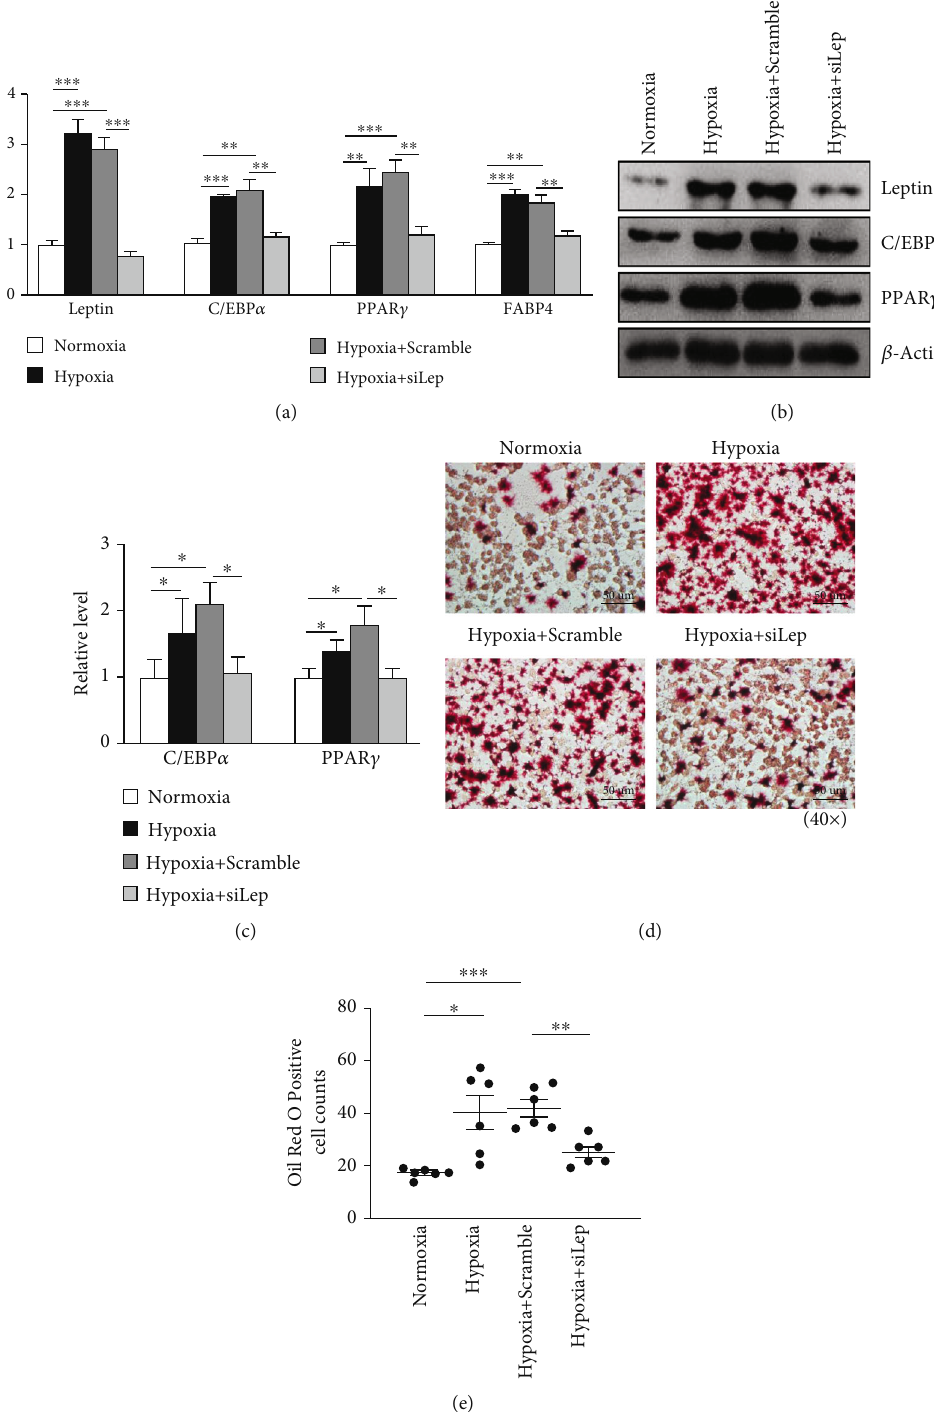
Figure 5: Knockdown of leptin attenuated the hypoxia-mediated increase of adipogenesis of RA-FLSs under hypoxia conditions. (a) RT-qPCR analysis of leptin and adipogenesis-related genes (C/EBP α , PPAR γ , and FABP4) in leptin-knockdown or scrambled siRNA control RA-FLSs after culture with adipogenic induction medium for 3 days under hypoxia and normoxia conditions. Data quanti fi cation is mean ± SEM ( t -test, three independent experiments). (b, c) Westen blot analysis of leptin and adipogenesis-related proteins (C/EBP α and PPAR γ ) in leptin-knockdown or scrambled siRNA control RA-FLSs after culture with adipogenic induction medium for 3 days under hypoxia and normoxia conditions. The expression normalized with β -actin ( t -test, three independent experiments). (d) Oil Red O staining of leptin-knockdown or scramble siRNA control RA-FLSs after culture with adipogenic induction medium for 21 days under hypoxia and normoxia conditions. (e) Oil Red O positive cells per fi eld were counted. Data quanti fi cation is mean ± SEM . ( t -test, six randomized fi elds, three independent experiments, and one representative experiment shown). ∗ p < 0 : 05 ; ∗∗ p < 0 : 01 ; ∗∗∗ p < 0 : 001 . Scale bars: C = 50 μ m